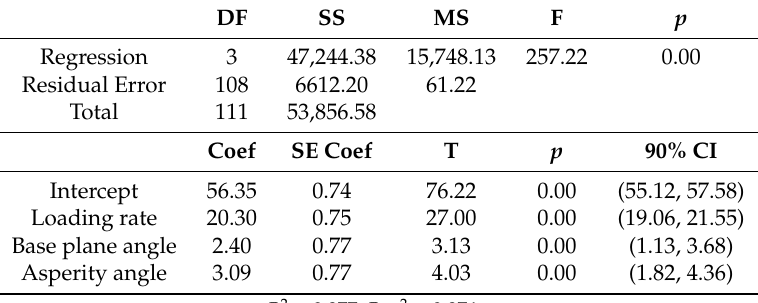
Table 5. Results of analysis of variance (ANOVA) for specimens with fracture failure. DF SS